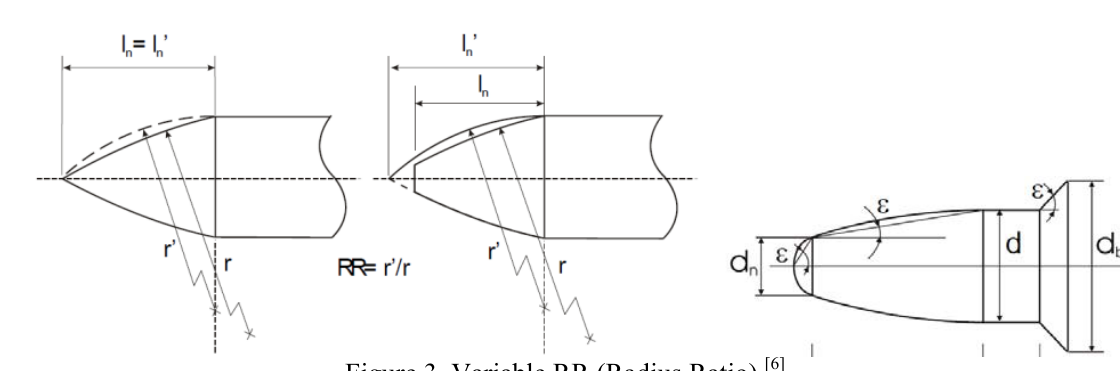
Figure 3. Variable RR (Radius Ratio)